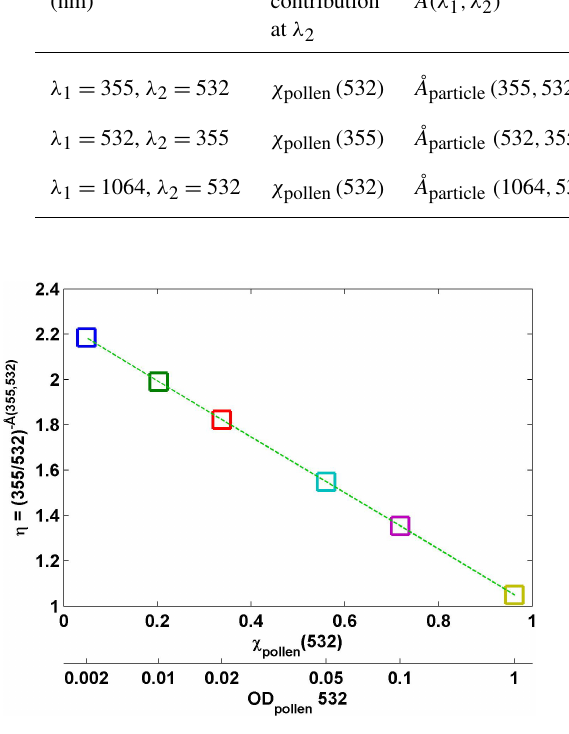
Figure 2. Scatter plot using the parameter η = ( 355 / 532 ) − Å ( 355 , 532 ) and pollen backscatter contribution ( χ pollen ) at 532nm for six simulated cases, of which the input values of pollen optical depth (OD pollen ) at 532nm are defined as 0.002, 0.01, 0.02, 0.05, 0.1, and 1 (shown on the bottom x axis), and the input value of background optical depth is fixed to be 0.1. Mean values of pollen layers (0–1km) are used for χ pollen and η . They line up perfectly following Eq.